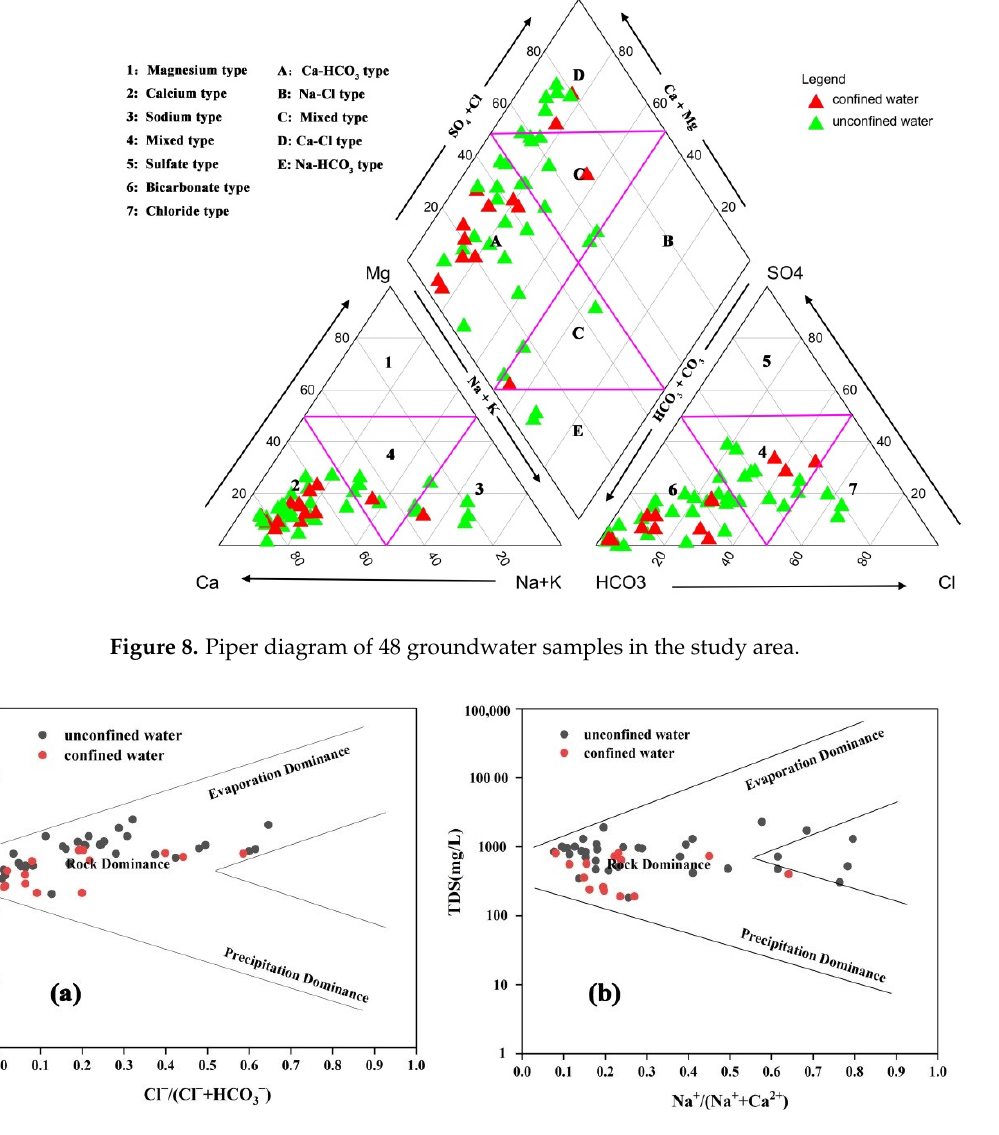
Figure 9. Gibbs diagrams of 48 groundwater samples in the study area. ( a ) TDS vs. [Cl − /(Cl − + HCO 3 − )]. ( b ) TDS vs. [Na + /(Na + + Ca 2+ )].